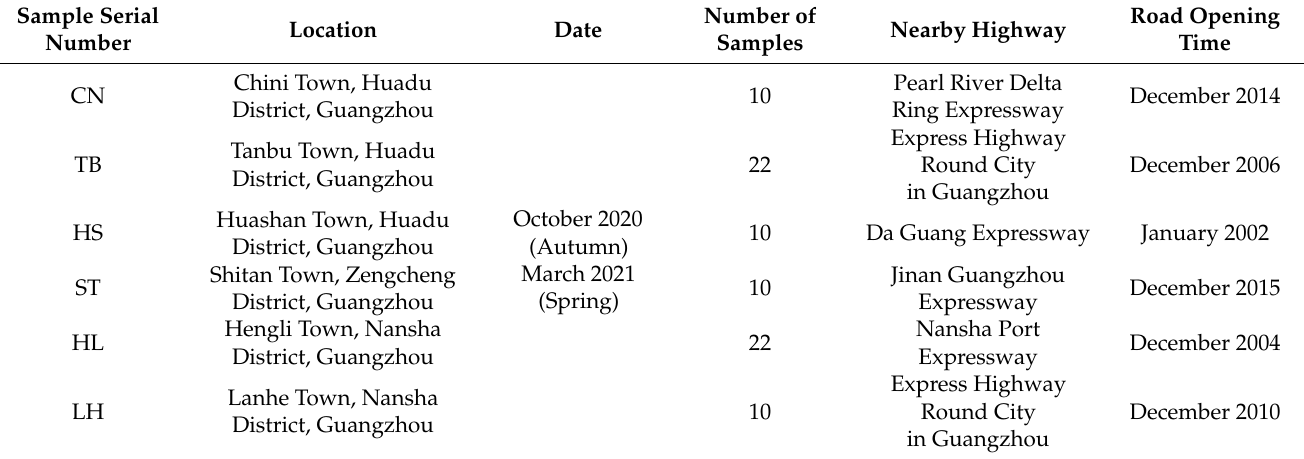
Table 1. Specific information for the six sampling